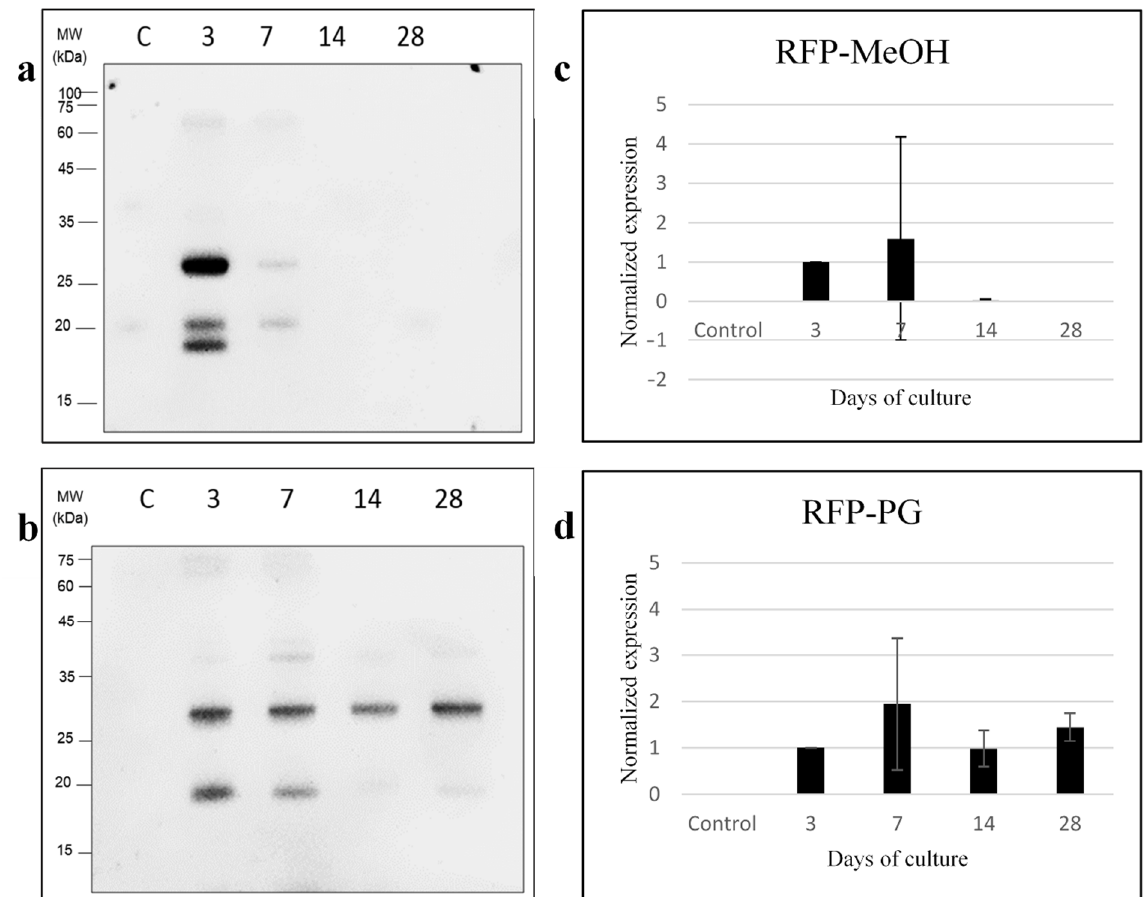
Figure 5. Western blot for Breviolum RFP expression for the ( a ) MeOH and ( b ) PG treatment groups after days of culture. The horizontal axis shows C as the control group (fresh Breviolum without freezing), and 3, 7, 14 and 28, as days of culture after thawing Breviolum RHP expression for the ( c ) MeOH and ( d ) PG treatment groups after same days of culture. The error bars represent standard deviation, and each group was repeated 3 times.